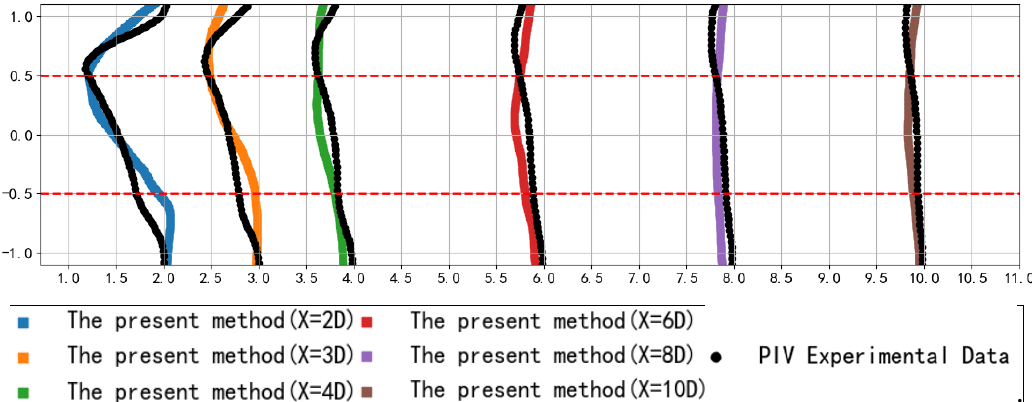
Figure 7. The comparison of average velocity profiles at six different cross-sections. The X-axis represents the sum of the two normalized parameters; one is the streamwise position, which is normalized by the turbine diameter ( X/D ), the other is the velocity deficit, which is normalized by the inflow velocity (Δ U/U 0 ). The Y-axis is the lateral position, which is normalized by the turbine diameter ( Y/D ). The data of black curves are from a published paper [10]; the color curves are calculated by the numerical method proposed in this paper.